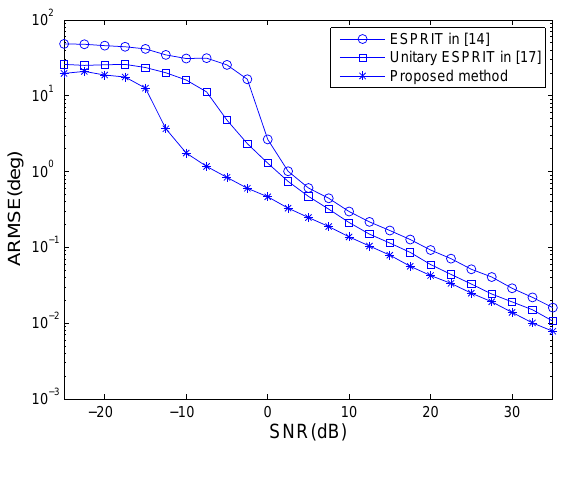
Figure 2. Average root mean square errors (ARMSEs) of angle estimation versus SNR.